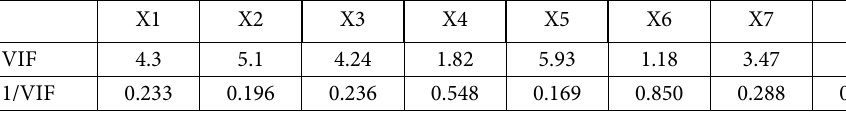
Table 9. The findings of Multicollinearity test results